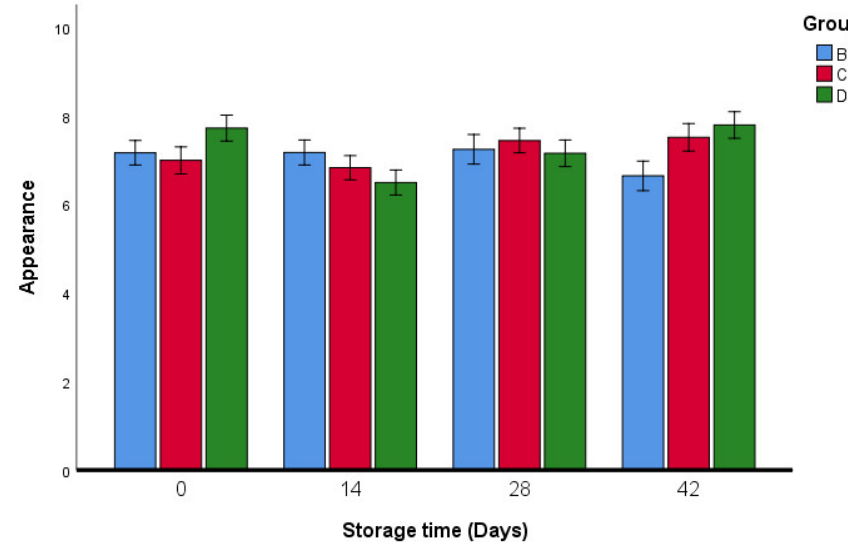
Figure 12. Appearance analysis of fresh oregano during storage period (42 days). Group B: (73.2% Fresh oregano, 15% Fresh Allium cepa , 20% corn oil, 1.8% salt), Group C: (61.9% Fresh oregano, 15% Fresh Allium cepa , 20% corn oil, 1.8% salt, 1.29% sumac “ Rhus coriaria ”), Group D: (59.2% Fresh oregano, 15% Fresh Allium cepa , 20% corn oil, 1.8% salt, 4% lactic Acid, ultimate pH 4.4.